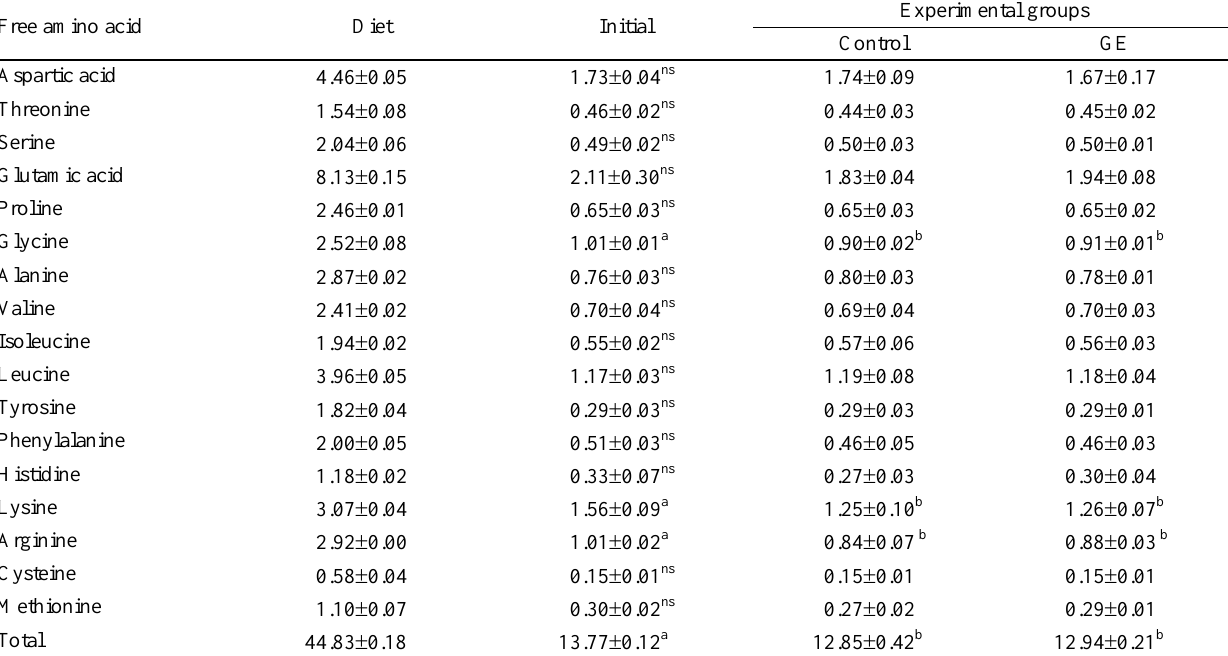
Experimental groups